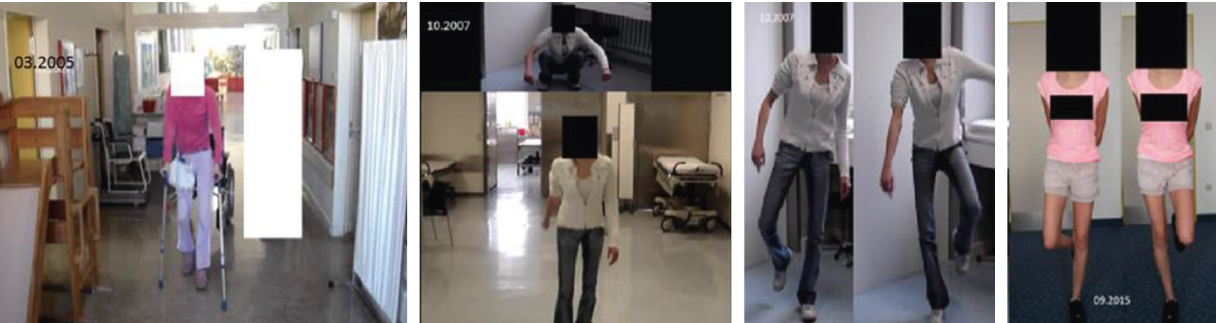
Figure 8: Improvement of gait and neurological status over time.